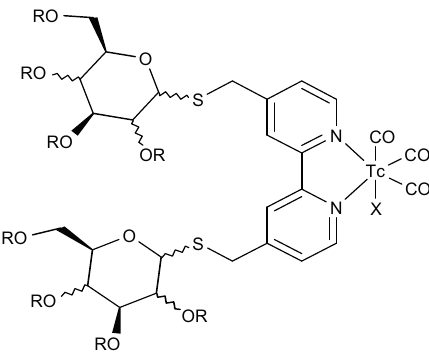
Figure 32. Example of bidentate 99m Tc complex: a sugar substituted bipyridine